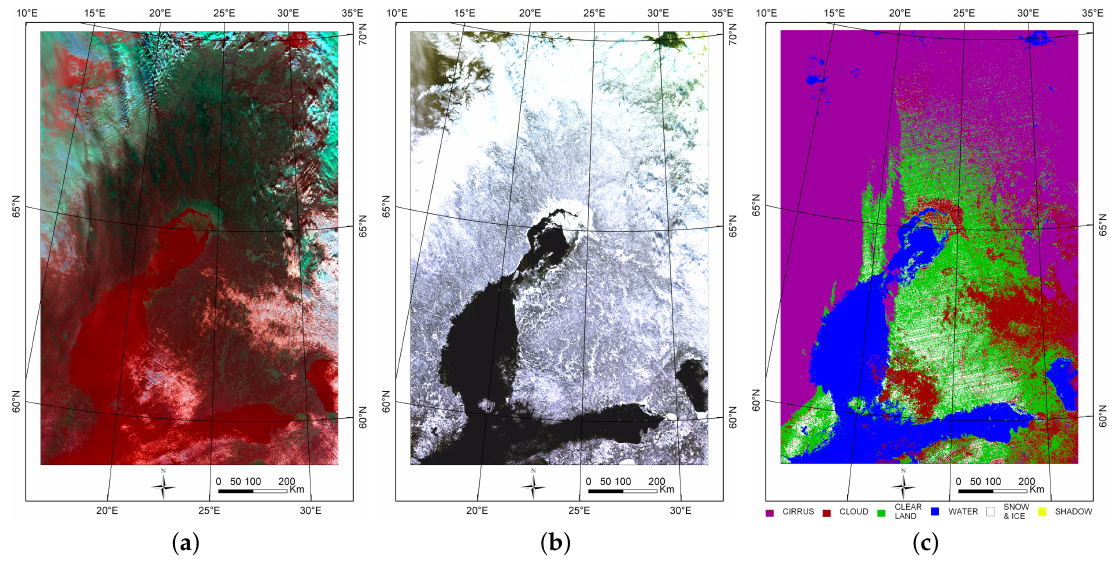
Figure 6. A Suomi NPP VIIRS image of 16 February 2016, at 10:57 a.m ( a ) SWIR colour composite, RGB composite from 3.7 µ m, 2.2 µ m and 1.6 µ m reflectance; ( b ) Natural colours, Natural colour image from 0.672 µ m, 0.555 µ m and 0.490 µ m reflectance; ( c ) Cloud/shadow result, Cloud and shadow detection